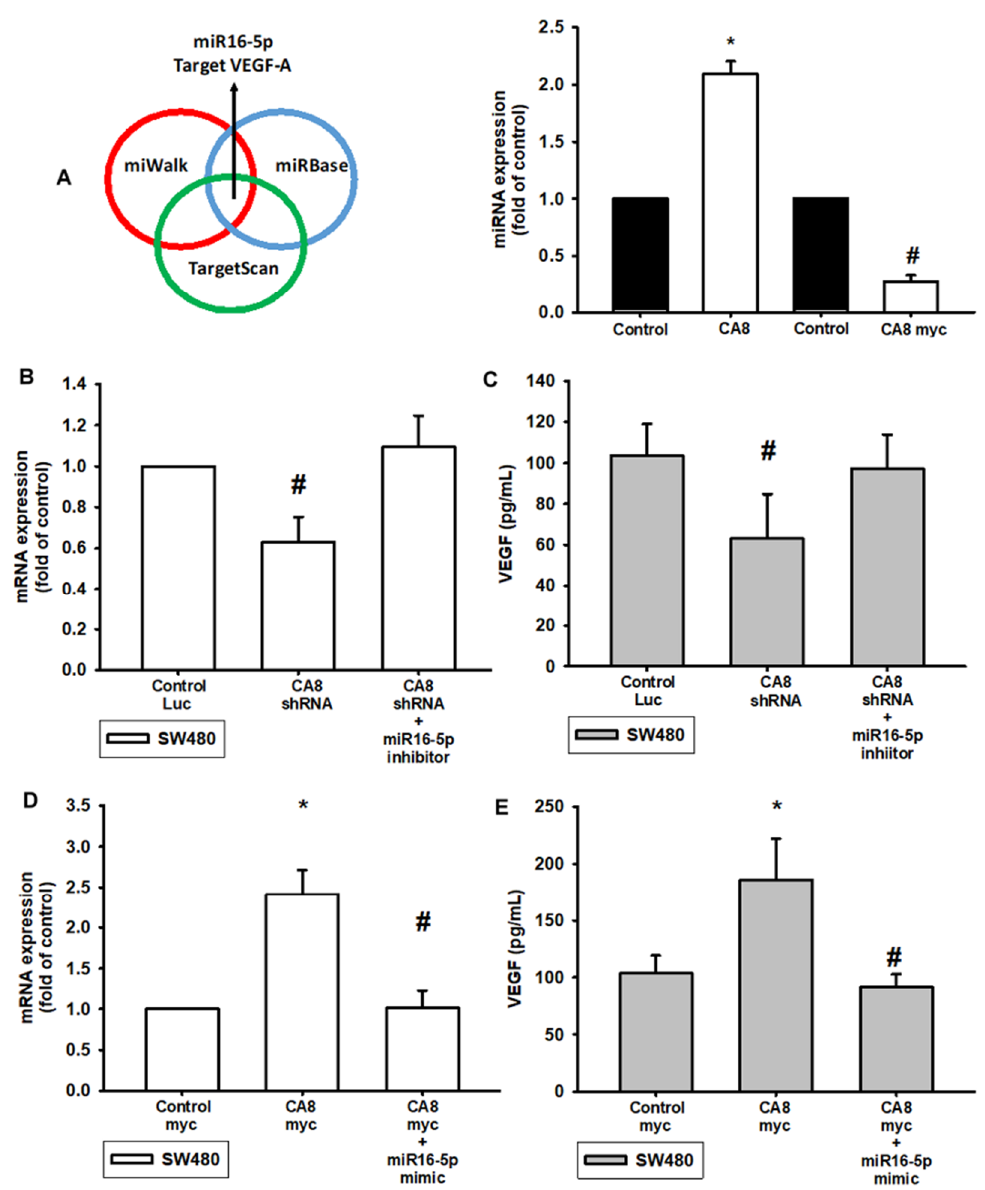
Figure 3. CAVIII increases production VEGF-A by suppressing miR16-5p expression. ( A ) Open- source software (TargetScan, miRDB, and miRWalk) sought to identify miRNAs that could possibly interfere with VEGF-A. SW480 cells were transfected with the indicated plasmids (CA8 shRNA or CA8 myc, 400 ng per well) and RNA was collected and extracted 24 h later. ( B , C ) VEGF mRNA and protein expression in CA8 knockdown cell lines (CA8 shRNA) and treatment with miR-16-5p inhibitor examined by qPCR and Western blot. ( D , E ) VEGF mRNA and protein expression in CA8 overexpression cell lines (CA8 myc) and treatment with miR-16-5p mimic examined by qPCR and Western blot. Results are expressed as the mean ± SEM. * p < 0.05 compared with controls; # p < 0.05 compared with the CA8 myc group.